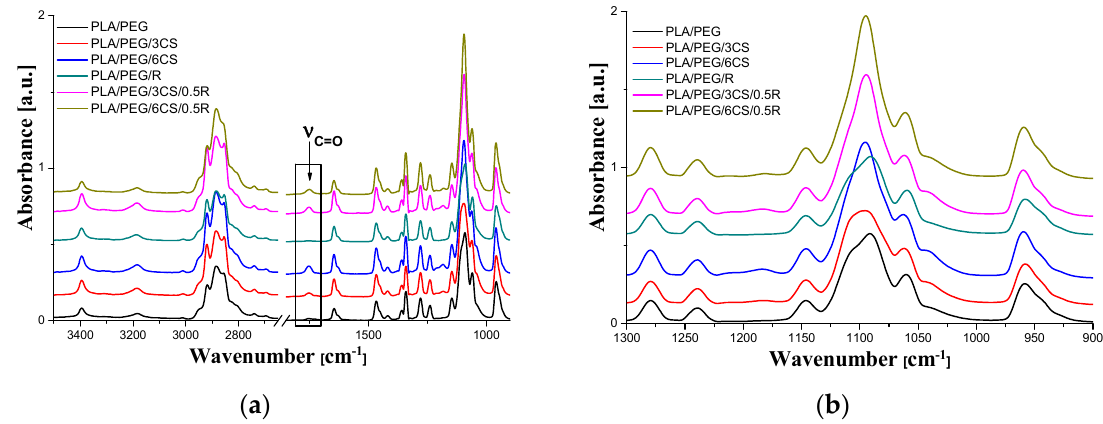
Figure 3. FT-IR results of the plasticized PLA, PLA / PEG / 3CS and 6CS, PLA / R, and PLA / PEG / CS / R: ( a ) entire wavenumber region (3500–600 cm − 1 ); and ( b ) 1000–1300 cm − 1 .